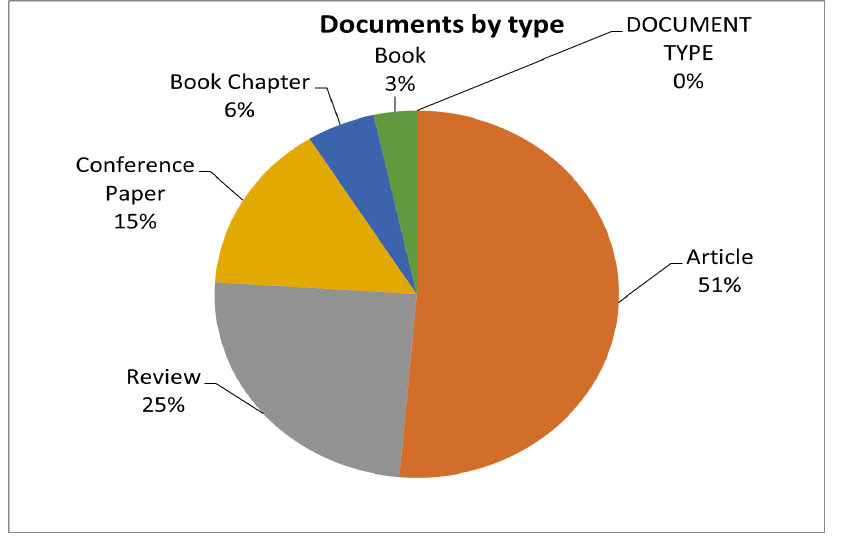
Figure 11. Source types of publications for IoT in agriculture.